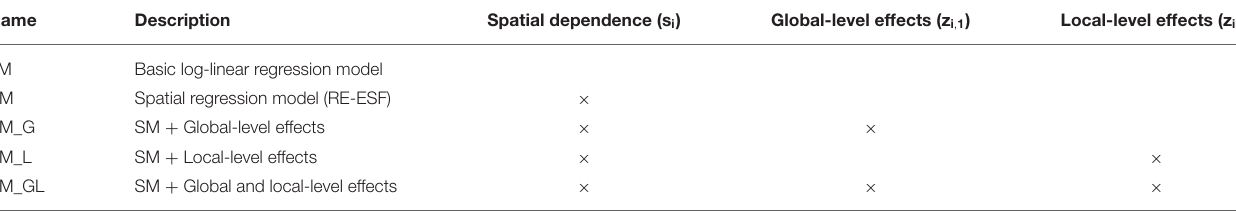
TABLE 2 | Summary of